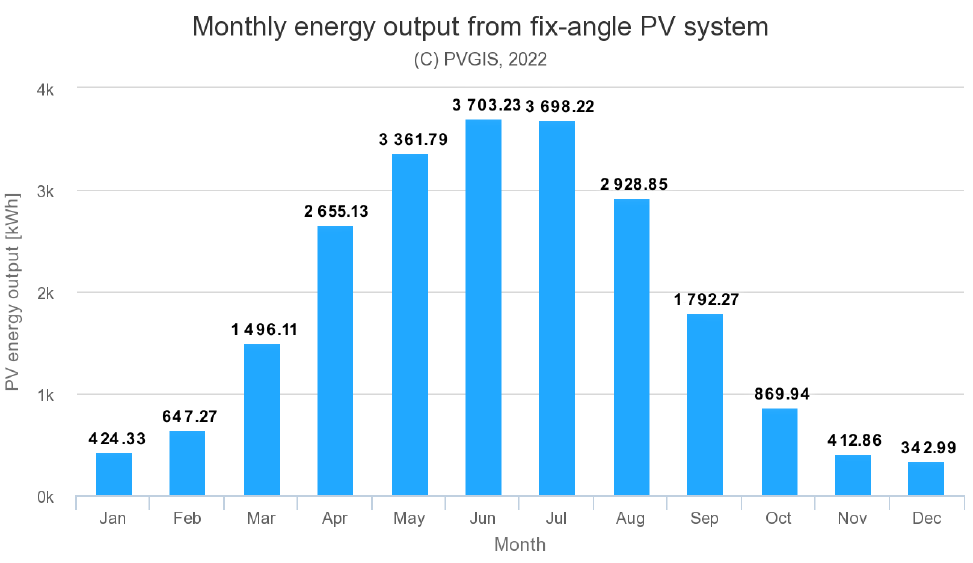
Figure 6. Monthly energy output of PV system calculated by the PVGIS application [32].